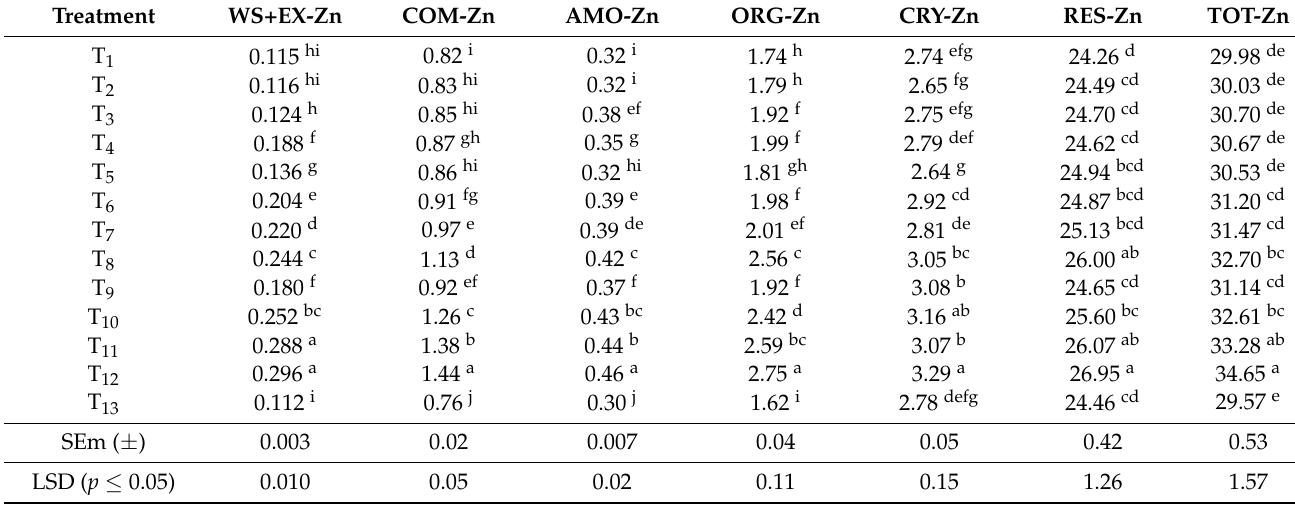
Table 2. Effect of different doses and frequencies of zinc application on the content of different fractions of zinc (mg kg − 1 ) in soil.